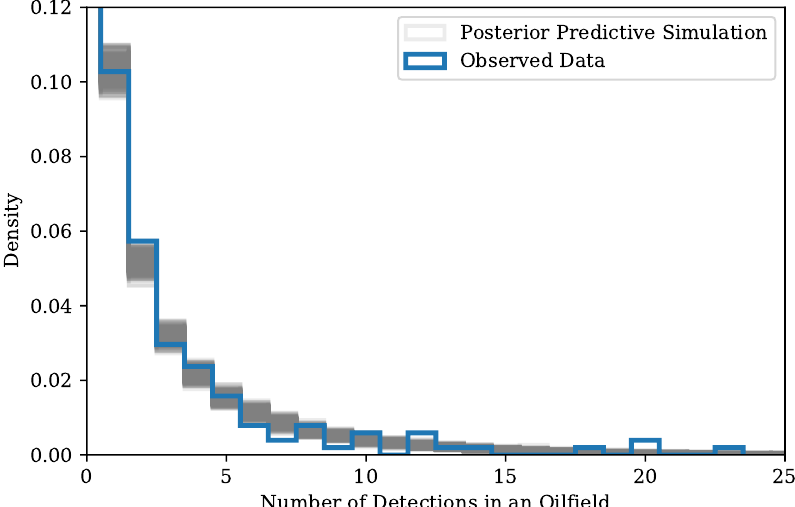
Figure 18. Histograms for the distribution of the field detection counts from October 2018, with the y -axis clipped to closely inspect those counts which are greater than or equal to